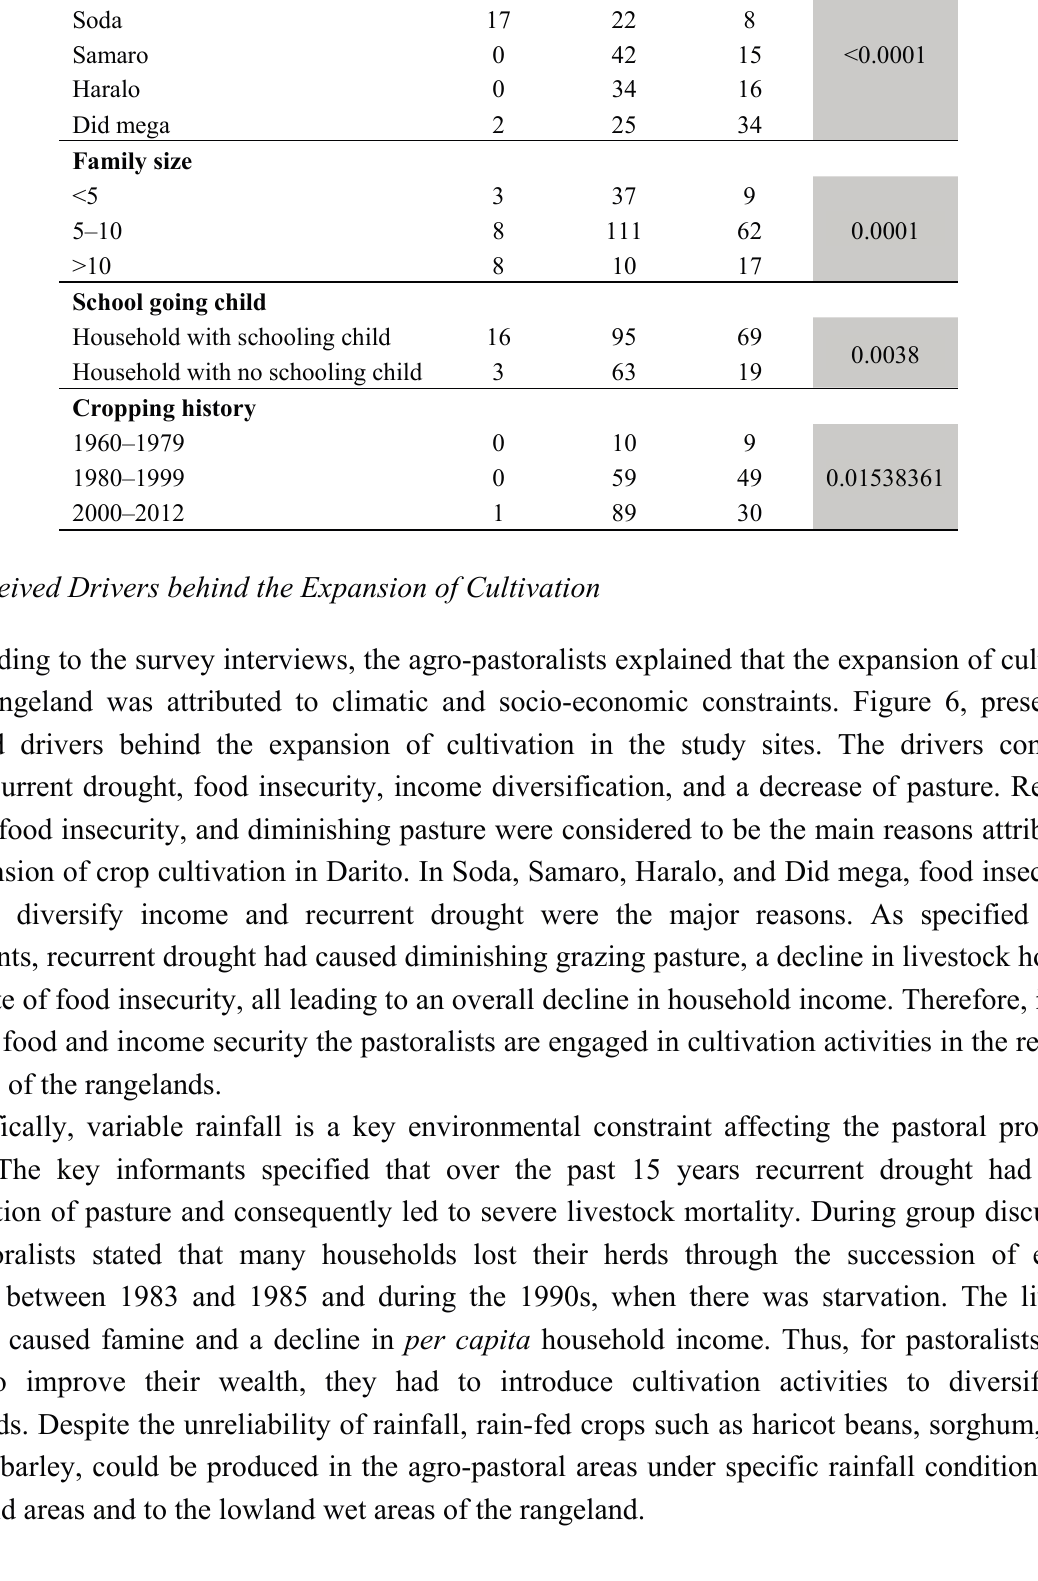
Table 6. Comparison of land size distribution (measured in hectares (ha)) in various sites across the Kebele, by family size, children in school, and cropping history ( X 2 test). 0 ha 1–2 ha >2 ha Kebele p –Value Numbers Numbers Numbers Darito